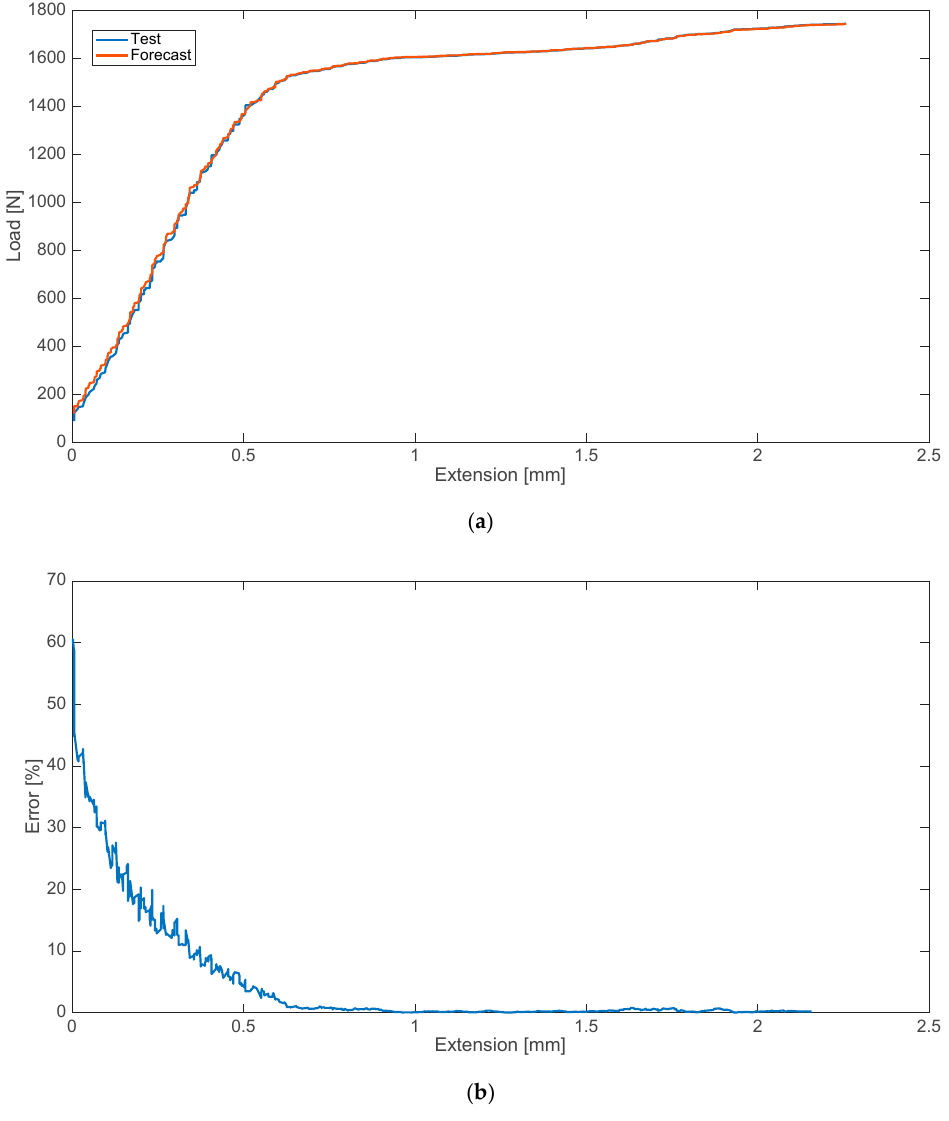
Figure 2. Strength characteristics ( a ) and error values ( b ) for 10% saline admixture.